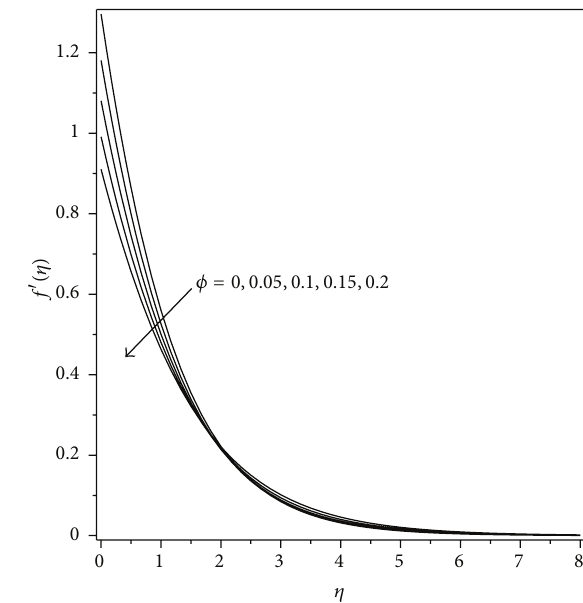
Figure 10: Dimensionless temperature profiles 𝜃(𝜂) for TiO 2 nanoparticles with 𝑚 = 0 and various values of 𝜙 .